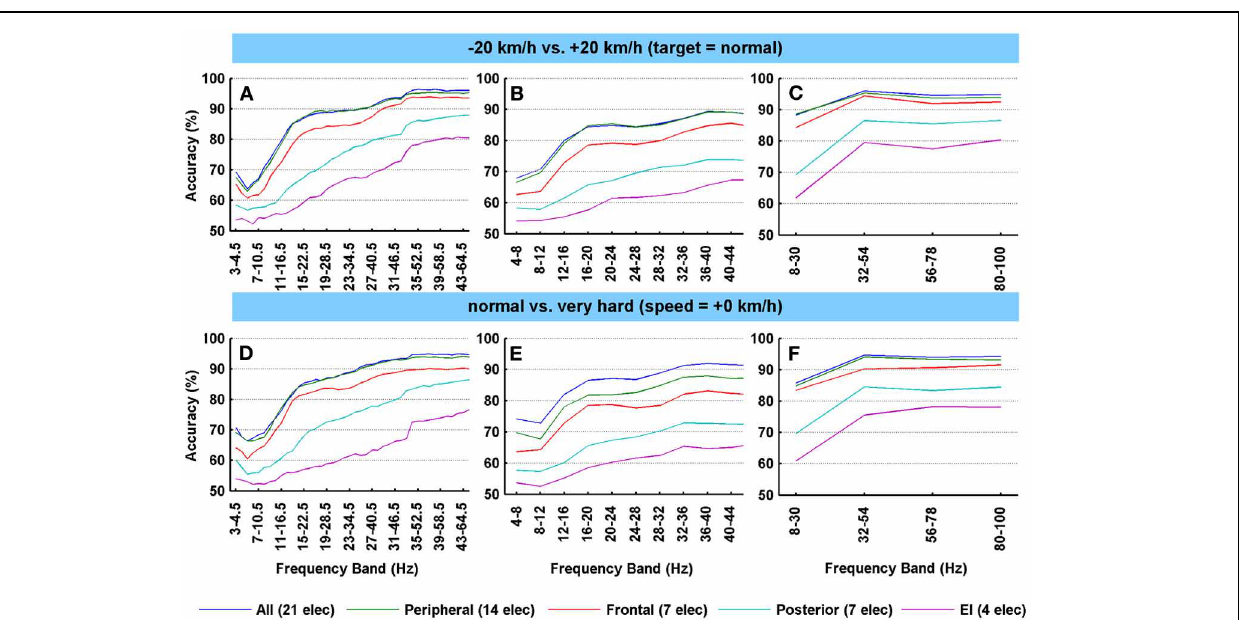
FIGURE 2 | Average classification accuracies of the Fisher’s linear discriminant analyses after spatial filtering for several condition pairs. (A–F) The accuracy values represent the average subject-specific classification accuracy over all participants that resulted from the cross-validation scheme. Classifications were based on applying the two most contrasting CSP components to the EEG channels. N = 26. For each row of subfigures, a different EEG cap configuration was used. For the left column (A,D) , the frequency bandwidth is 1.5 times the